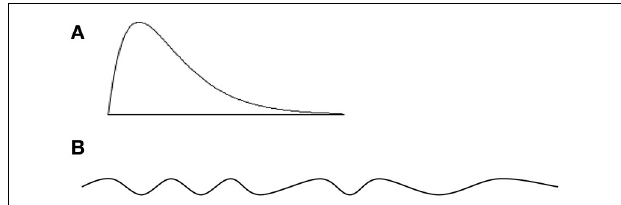
FIGURE 1 | (A) Ditransitive distribution. Ditransitive {give, give, give, give, read, pass}. (B) Transitive distribution. Transitive {get, have, want, take, find, put, do, eat, play, see, like, say...}. Figure from Ibbotson and Tomasello